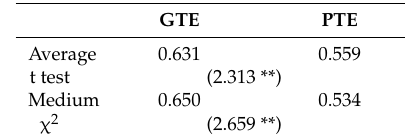
Table 7. Group technical efficiency (GTE) and pool technical efficiency (PTE).